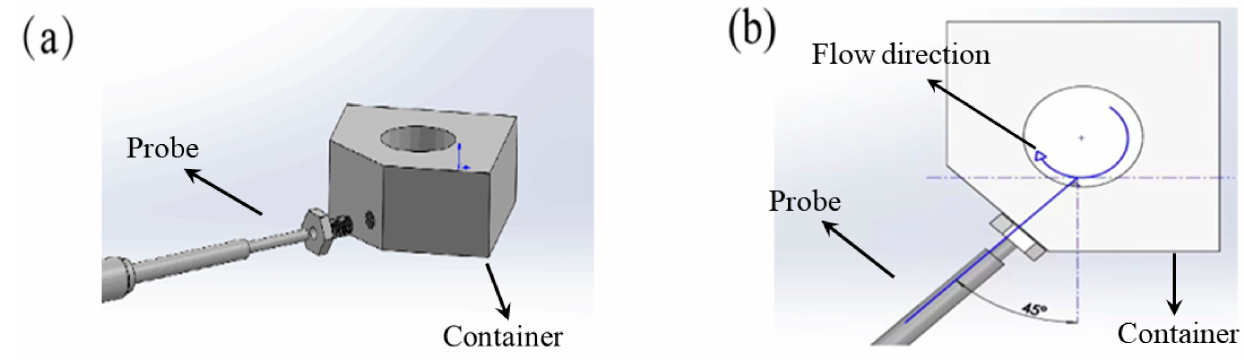
Figure 5. Configuration of custom-built container to accommodate the FBRM probe: ( a ) stereogram; ( b ) vertical view.